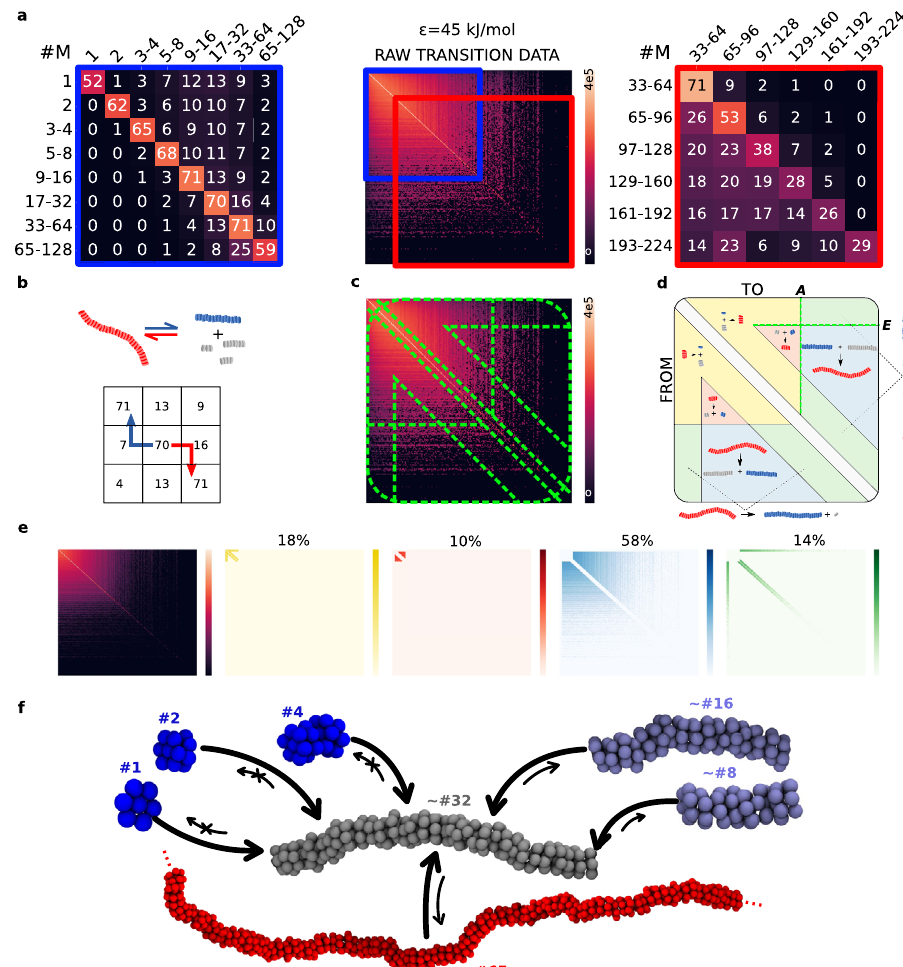
Fig. 3 The dynamic nature of a supramolecular polymer system. Results are reported for the ϵ = 45 kJ mol − 1 system (other cases are reported in the SI). a The transition matrix obtained from CG-MD with sampling interval Δ τ = 300 ps (centre). The left and right panels report two sub-regions of the transition probability matrix (red and blue rectangles). Here, the size of the aggregates are grouped for clarity. The numbers in the cells indicate the percentage probability (the 0s identify transitions with probability ≤ 0.5%, see Supplementary Fig. 13). The colouring of the matrix cells mirrors the entry values (with logarithmic scale for the raw transition data matrix). b Illustrative scheme interpreting the transition matrices in terms of polymerisation (red arrow) and depolymerisation (blue arrow) events. c Matrix partitioned in areas indicating the different polymerisation/depolymerisation mechanisms. d Diagram associating the different polymerisation/depolymerisation mechanisms to the different regions of the transition matrix. e Matrix counting the assembly transitions (left) decomposed into areas (as in d ) identifying different classes of polymerisation/depolymerisation mechanisms (see Methods for details). f Dynamic interconnections between a 32 monomer aggregate (grey) and smaller (blue) or larger assemblies via fragmentation into shorter fi bres. The scheme of Fig. 3d identi fi es those regions of the transition matrix (i.e., Fig. 3c) that refer to such different classes of events: involving the exchange of small size aggregates (yellow and green areas) or the coalescence/ fragmentation of medium/large constructs (red and blue areas).